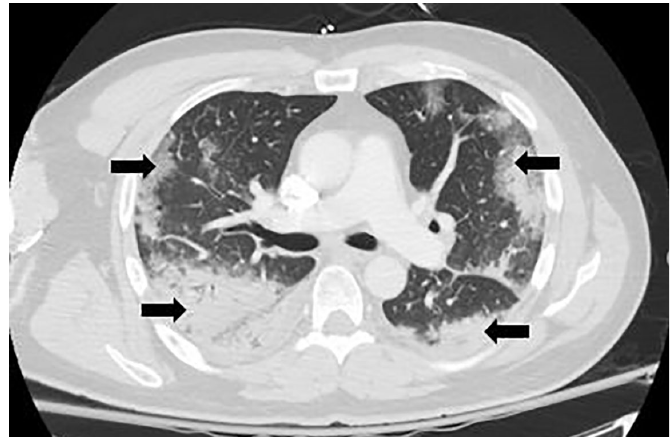
Image 2. Computed tomography of the chest two days after admission demonstrating extensive, bilateral multifocal pneumonia most notable in the lower lobes (arrows).